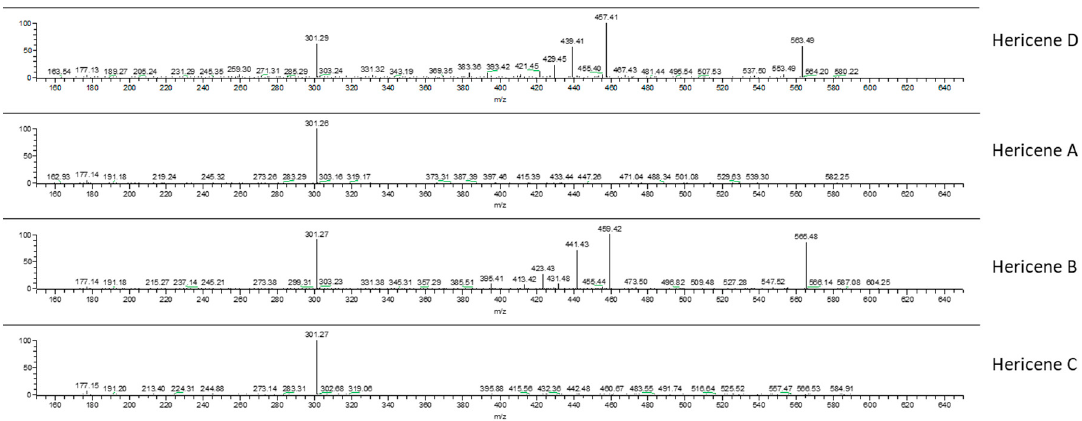
Figure 4. MS / MS-ESI spectra of hericenes D, A, B, and C (from top to bottom). Figure 4. MS/MS-ESI spectra of hericenes D, A, B, and C (from top to bottom). Figure 4. MS/MS-ESI spectra of hericenes D, A, B, and C (from top to bottom).